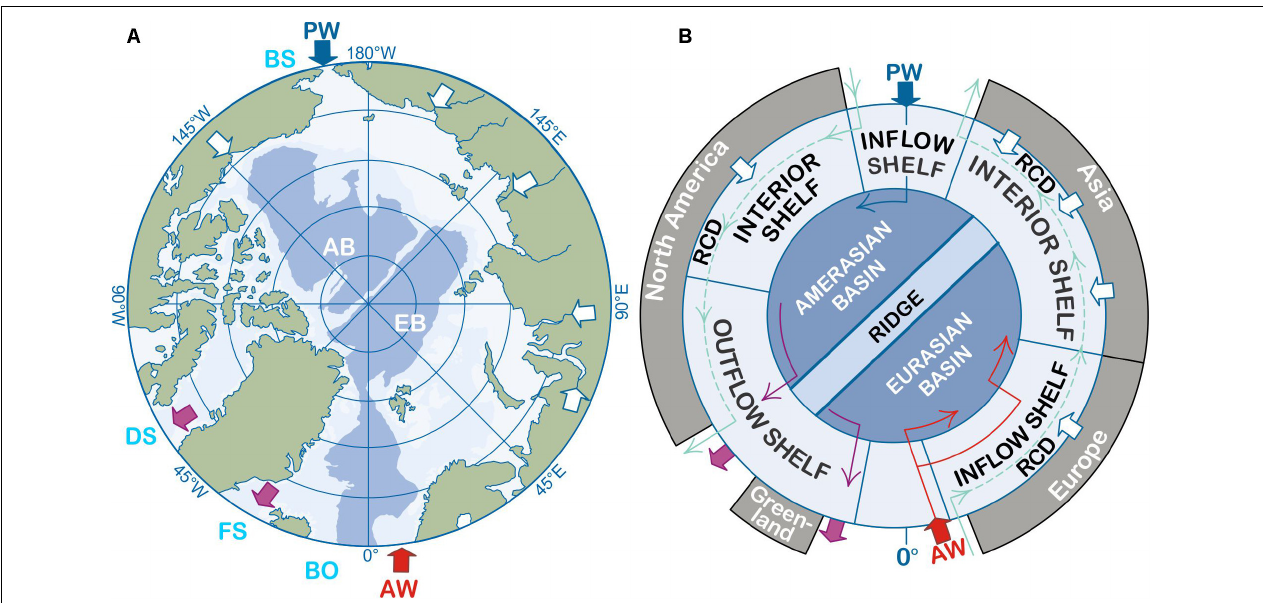
FIGURE 1 | Map of the arctic marine system. (A) Polar projection of the Arctic Ocean showing a simplified version of bathymetry, highlighting the deep Amerasian and Eurasian Basins (AB, EB; dark shading) and shallow shelves (light shading), along with idealized Pacific Water (PW) inputs via Bering Strait (BS), Atlantic Water (AW) inflows via the Barents Opening (BO), and major river inputs with blue, red, and white arrows, respectively. Outflows from the AO via the Davis Strait (DS) and Fram Strait (FS) gateways are illustrated with purple arrows; and (B) the highly idealized hydromorphological domains redrawn from Bluhm et al. (2015), where the RCD refers to the Riverine Coastal Domain (see Carmack et al., 2015b,c), major inflow and outflow arrows as in (A)